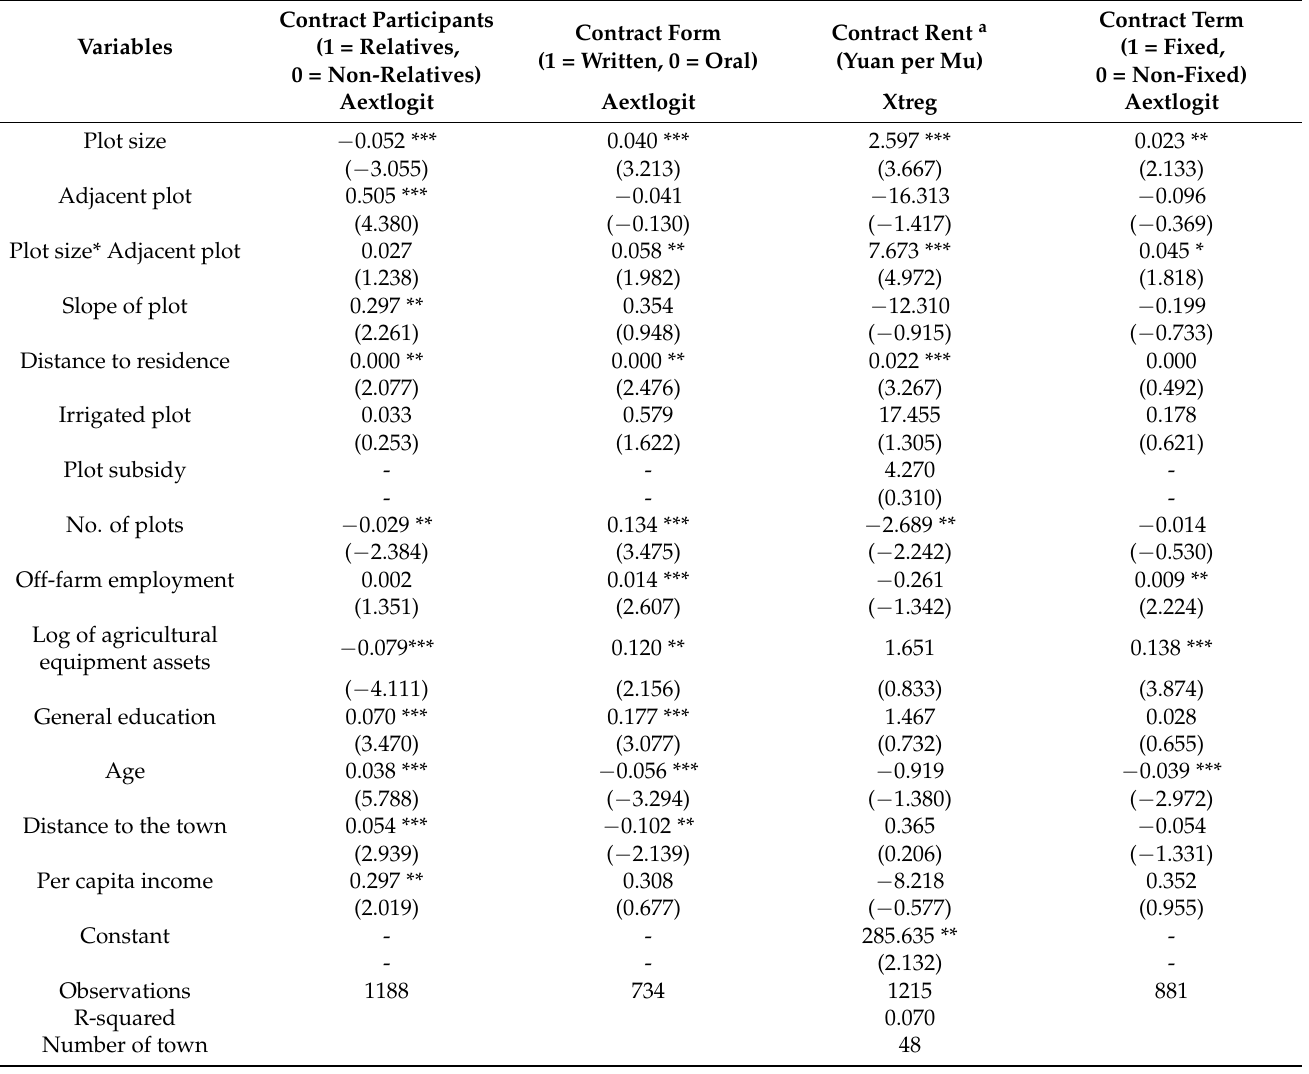
Table A3. The impact of the size of rented-in plots on contract choice with town fixed effect and cross term.